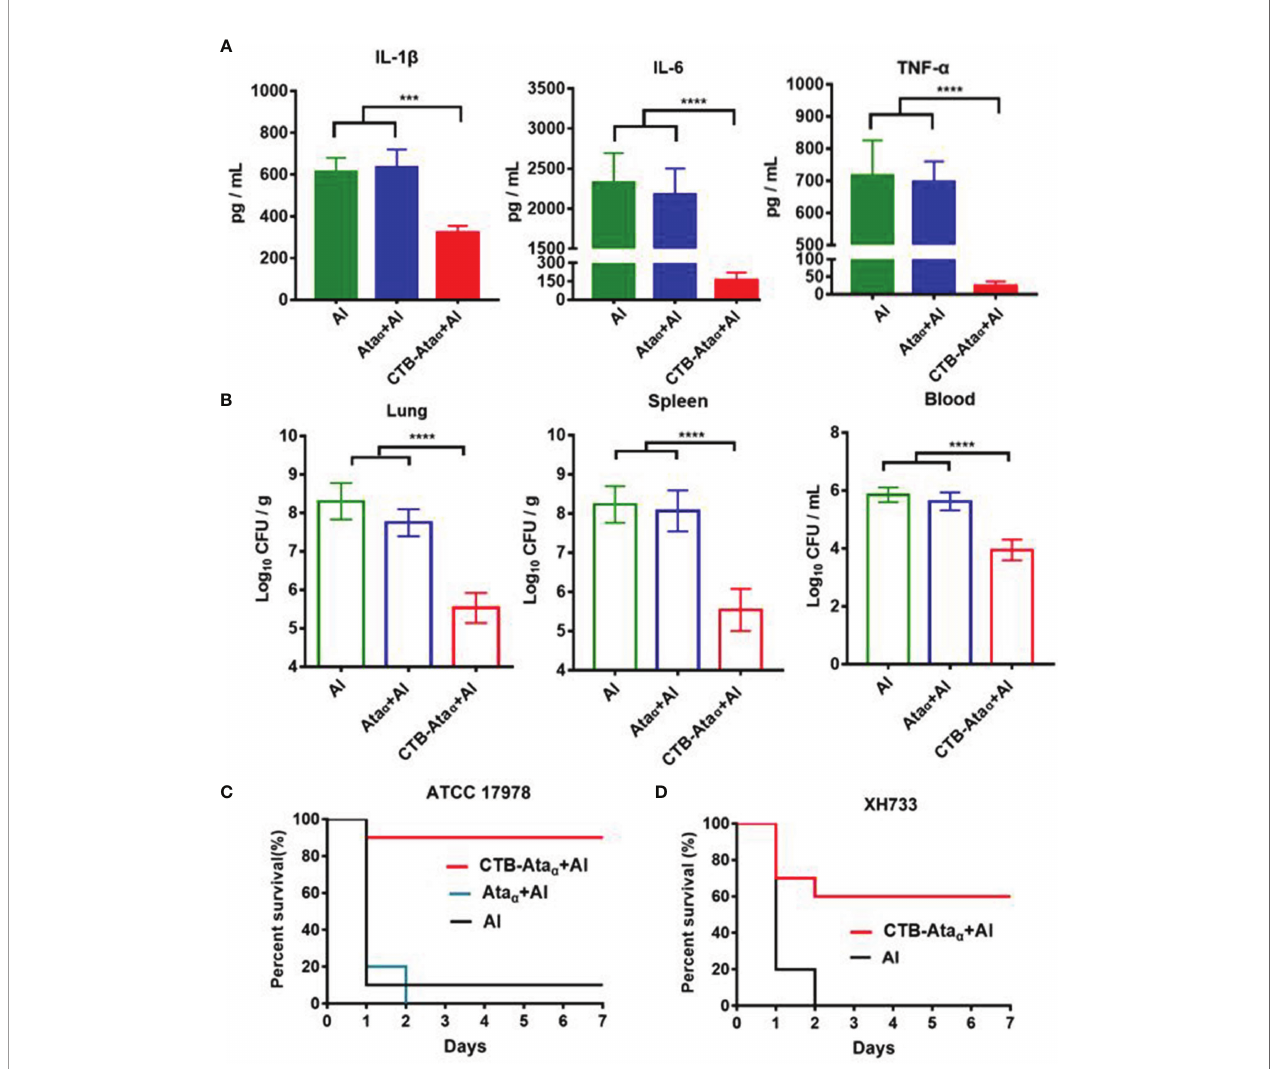
FIGURE 4 | Ef fi cacy evaluation of the CTB-Ata a vaccine. (A) In fl ammatory cytokine levels 12 h post-challenge with a sublethal dose. (B) Bacterial loads of lung, spleen, and blood 12 h post-challenge with a sublethal dose. (C, D) Survival rates post-challenge with a lethal dose. ATCC 17978 (4.9 × 10 7 CFU) and XH733 (4.5 × 10 7 CFU) were intraperitoneally injected 14 days after the third injection. Data are presented as means ± s.d. Each group was compared using one-way ANOVA with Dunnett ’ s multiple-comparison test. **** P < 0.0001, *** P <